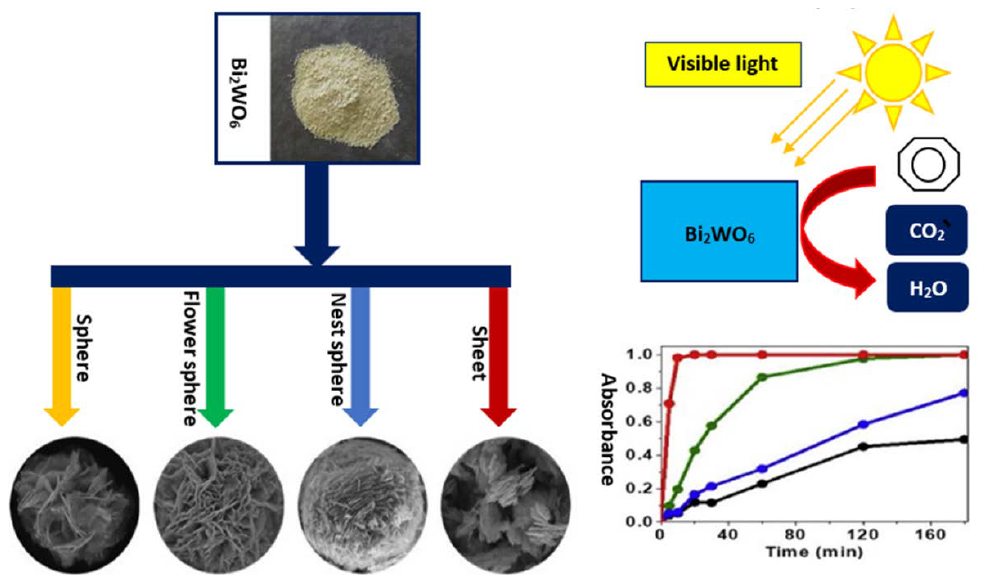
Figure 7. The morphology-dependent nature of Bi 2 WO 6 photocatalysts on the degradation of volatile organic compounds under visible light.